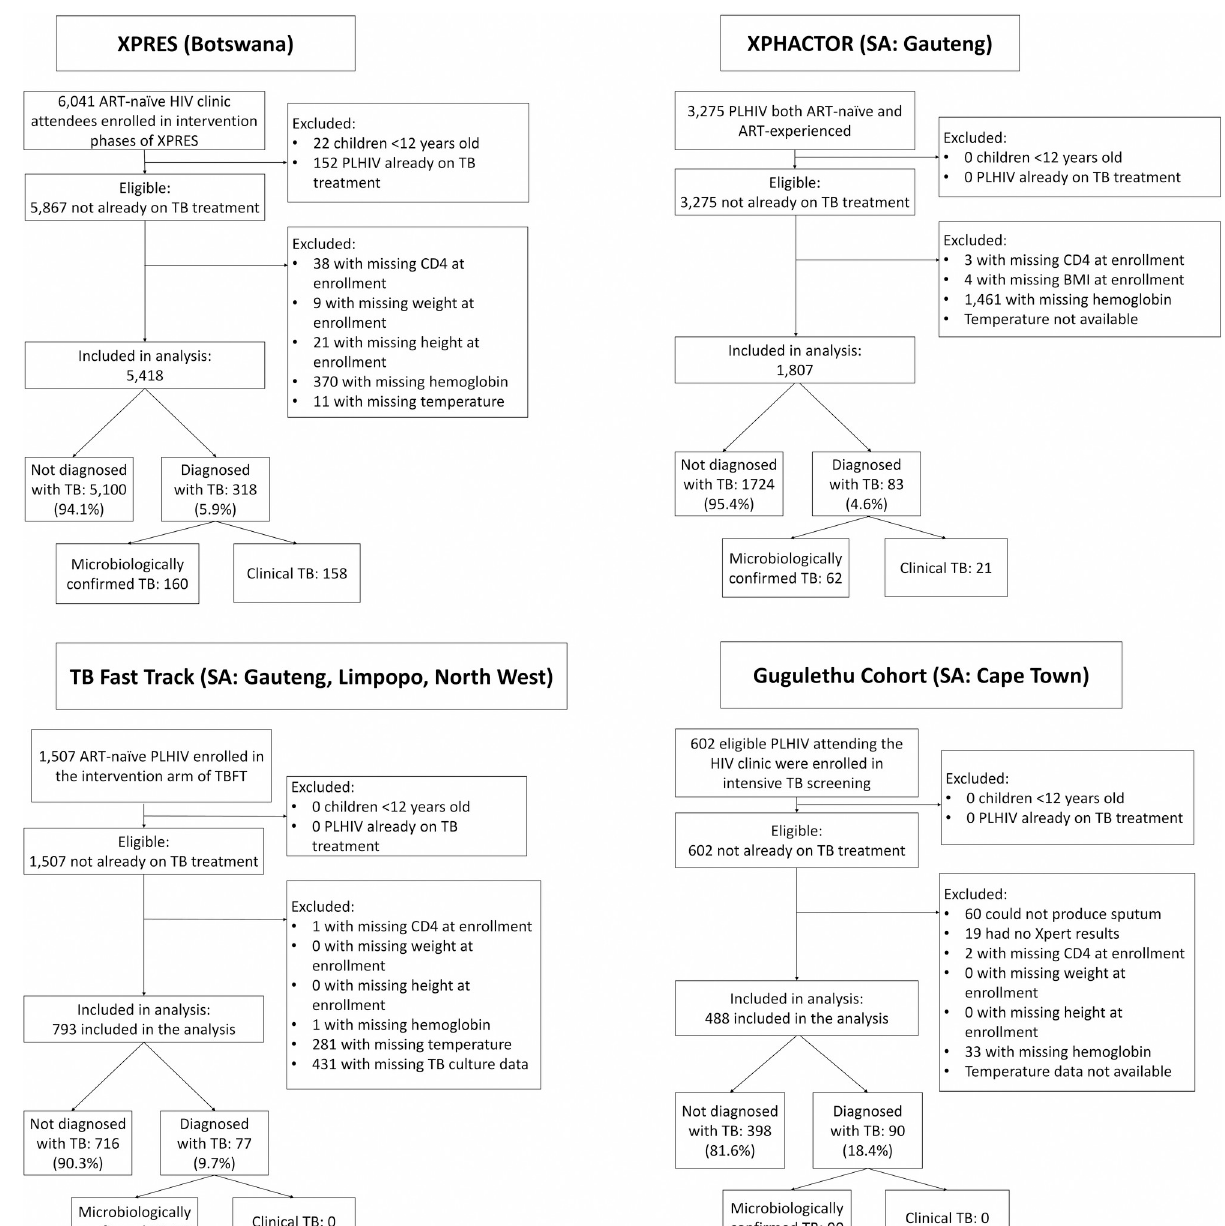
Fig 1. Study profiles for the derivation and validation datasets. A AU : AbbreviationlistshavebeencompiledforthoseusedthroughoutFigs 1 (cid:0) 5 : Pleaseverifythatallentriesarecorrect : RT, antiretroviral therapy; PLHIV, people living with HIV; SA, South Africa; TB, tuberculosis; TBFT, TB Fast Track. smoking history, presence/absence of � 1 WHO TB symptom, BMI (as a transformed term per the MFP analysis), temperature (modeled as 2 transformed terms per the MFP analysis), and hemoglobin concentration (continuous, linear term) (Table 2). There was no substantial corre- lation between measured temperature in its transformed or linear form and reported fever (Pearson correlation coefficient (r) = 0.1316) or between measured temperature and � 1 reported WHO TB symptom (r = 0.0846).